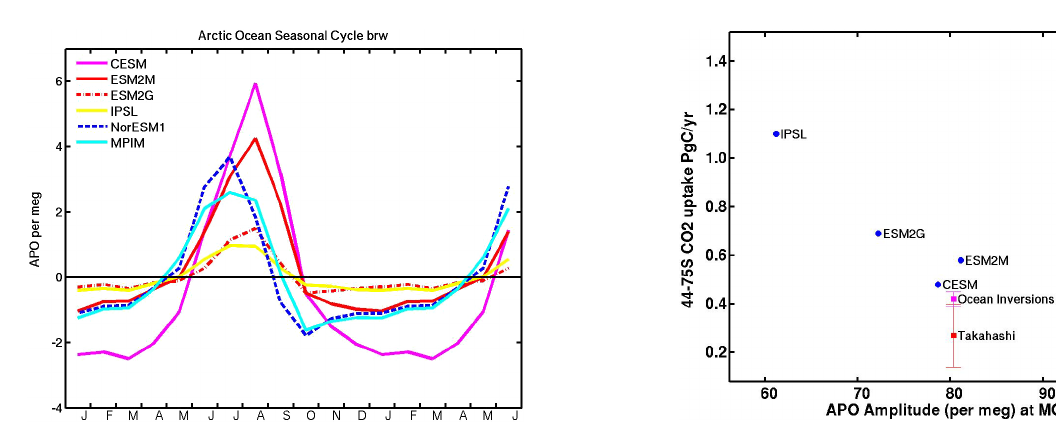
Figure 9. APO cycle at Barrow, Alaska, from the TransCom north- ern oceans region, restricted to latitudes north of 65 ◦ N to estimate the contribution of the Arctic Ocean. All curves reflect the unscaled model mean of 13 ATMs used in the matrix method.